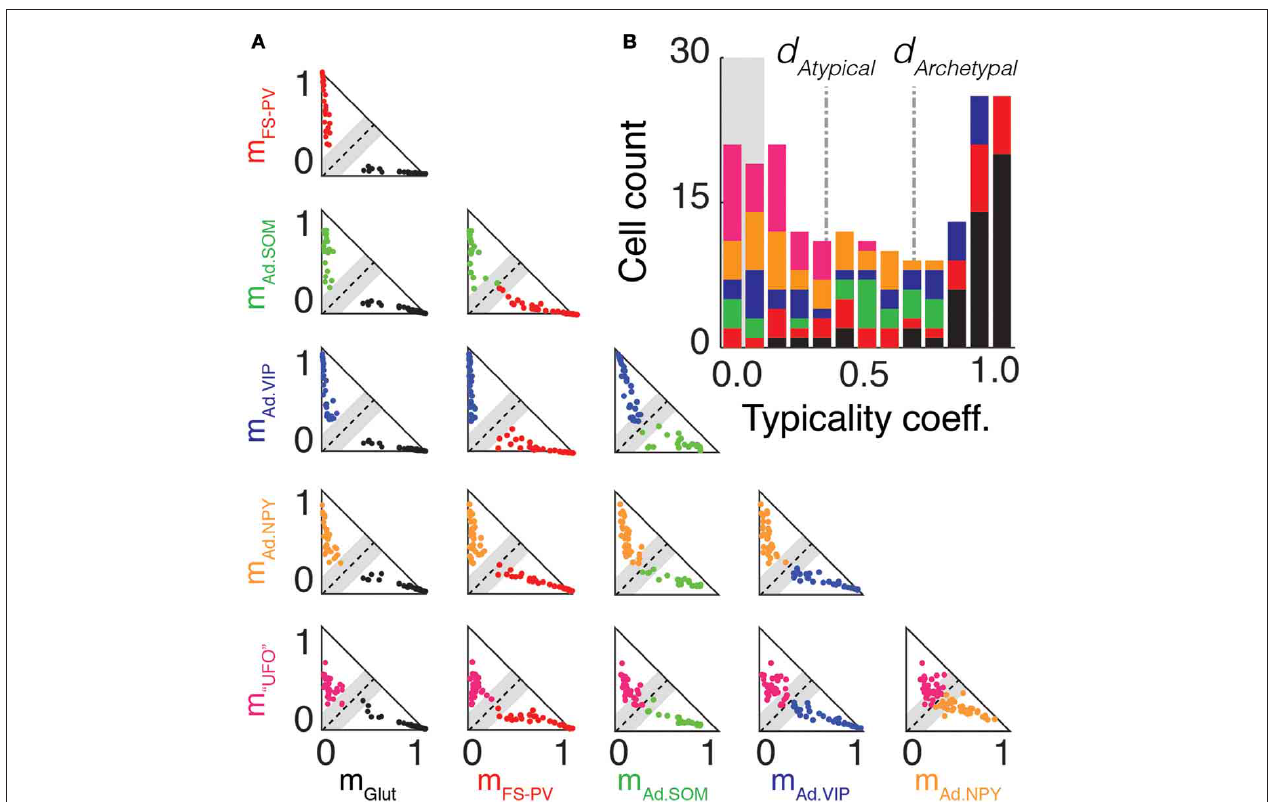
Glutamatergic, FS-PV, and Adapting VIP neurons. (B) Overall distribution of typicality coefficients. The right and left peaks correspond to archetypal and atypical cells, respectively. The grayed background denotes the range of typicalities associated to edge cells. In the stacked histogram, sections with different colors indicate cells with different main type. Archetypal and atypical cells are unequally distributed across archetypes. The bimodal distribution indicates that archetypes tend to separate, but only